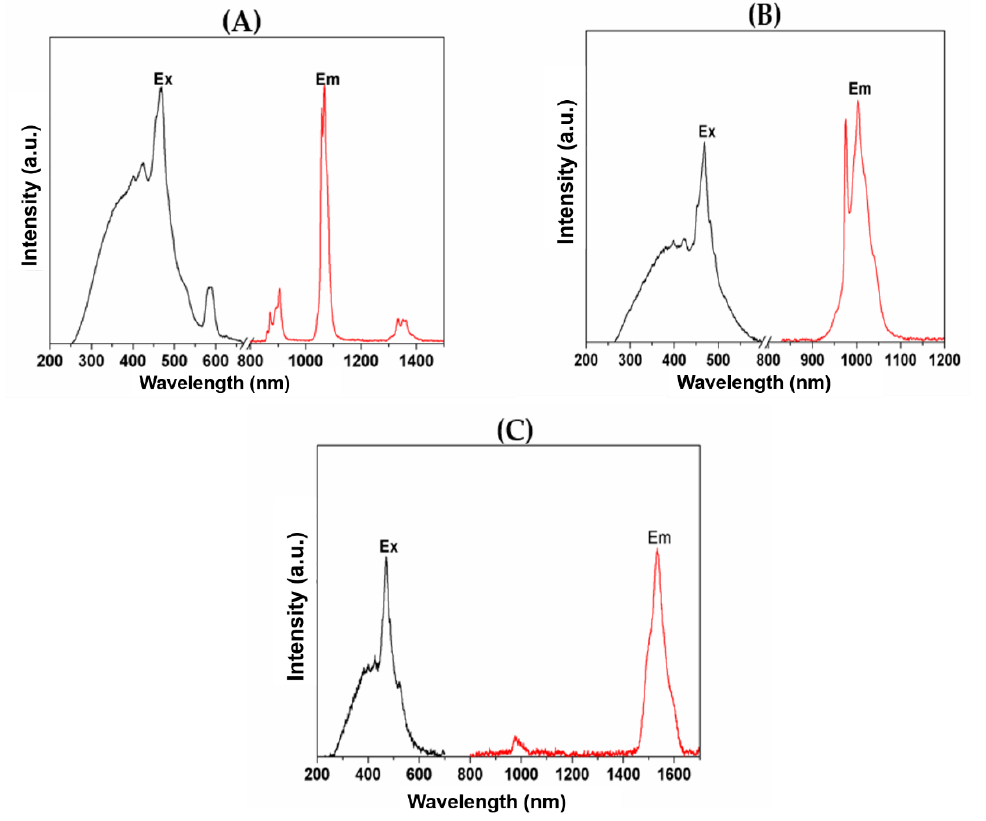
Figure 3. Excitation and emission spectra of Ln(Q-POSS) 3 . ( A ) Nd (Q-POSS) 3 (λ ex = 469 nm, λ monitor = λ λ ex = 469 nm, λ 1068 nm), ( B ) Yb (Q-POSS) 3 (λ ex = 469 nm, λ monitor = 980 nm), and ( C ) Er(Q-POSS) 3 (λ ex = 471 nm, λ monitor monitor = 1068 nm), ( B ) Yb (Q-POSS) 3 ( monitor = 980 nm), and ( C ) Er(Q-POSS) 3 ( λ ex = 471 nm, λ monitor = 1536 = 1536 nm).